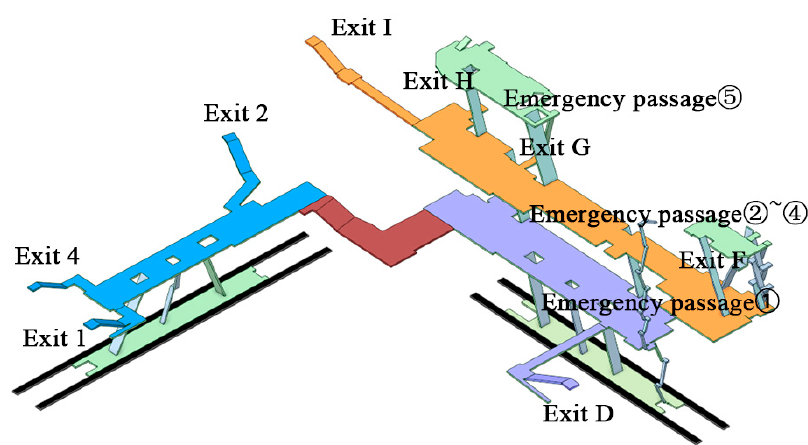
Figure 7. Schematic diagram of the evacuation passages.